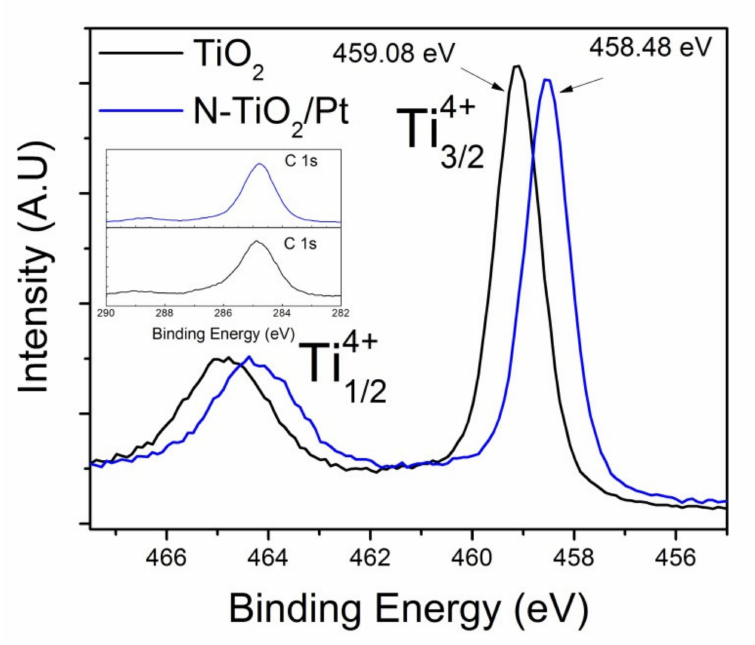
Figure 4. XPS spectra in the Ti2p region for TiO 2 and N-TiO 2 − x /Pt (2 h nitrogen plasma treatment).